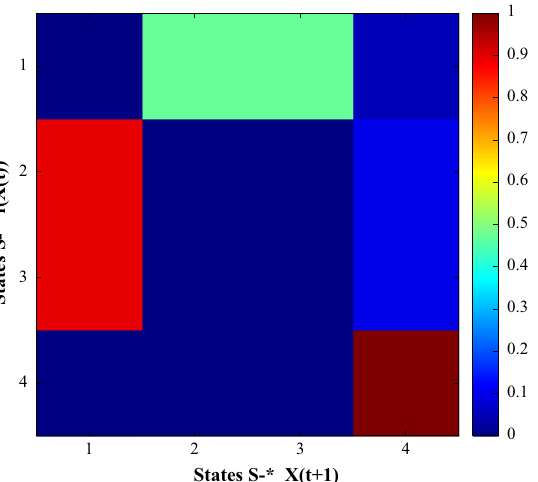
Fig. 7 Transition probability matrix heatmap with CCFs